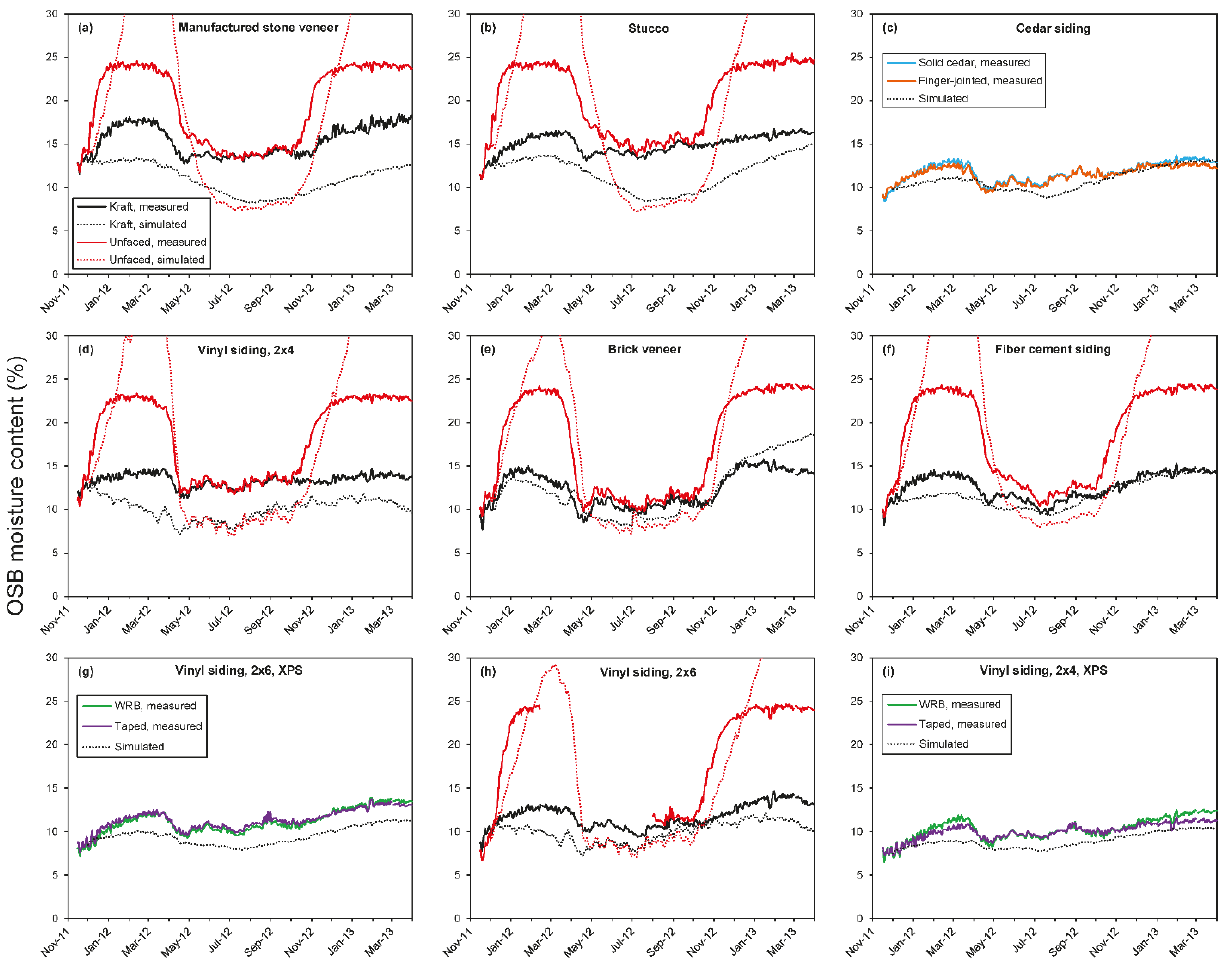
Figure 11. Measured and simulated OSB moisture content in north-facing